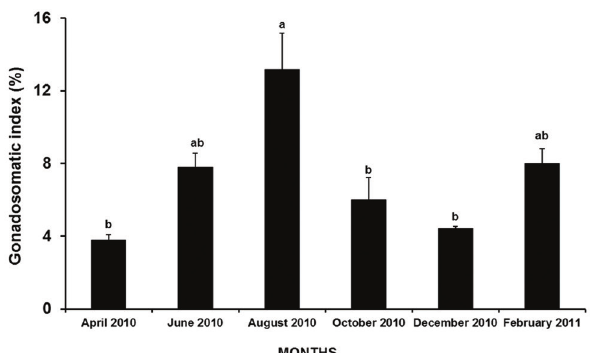
Fig. 1. Mean ( ± S.E.M) bimonthly variations of the gonadosomat- ic index in Metynnis maculatus females (n = 36). The different letters indicate significant differences among months. (ANOVA, Tukey test, P < 0.05).